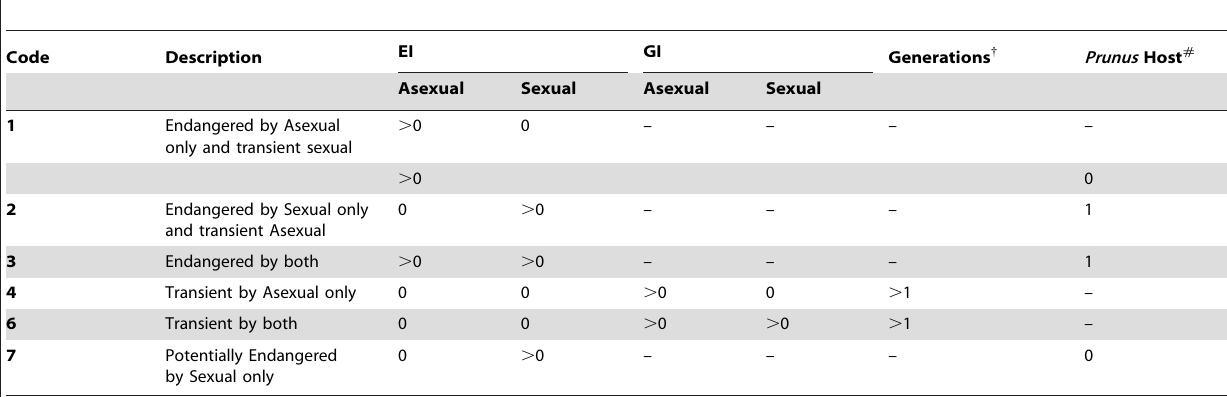
Table 2. Classification of invasion risk categories based on the International Standard for Phytosanitary Measures (ISPM) (FAO 2006) used for the classification of Rhopalosiphum padi